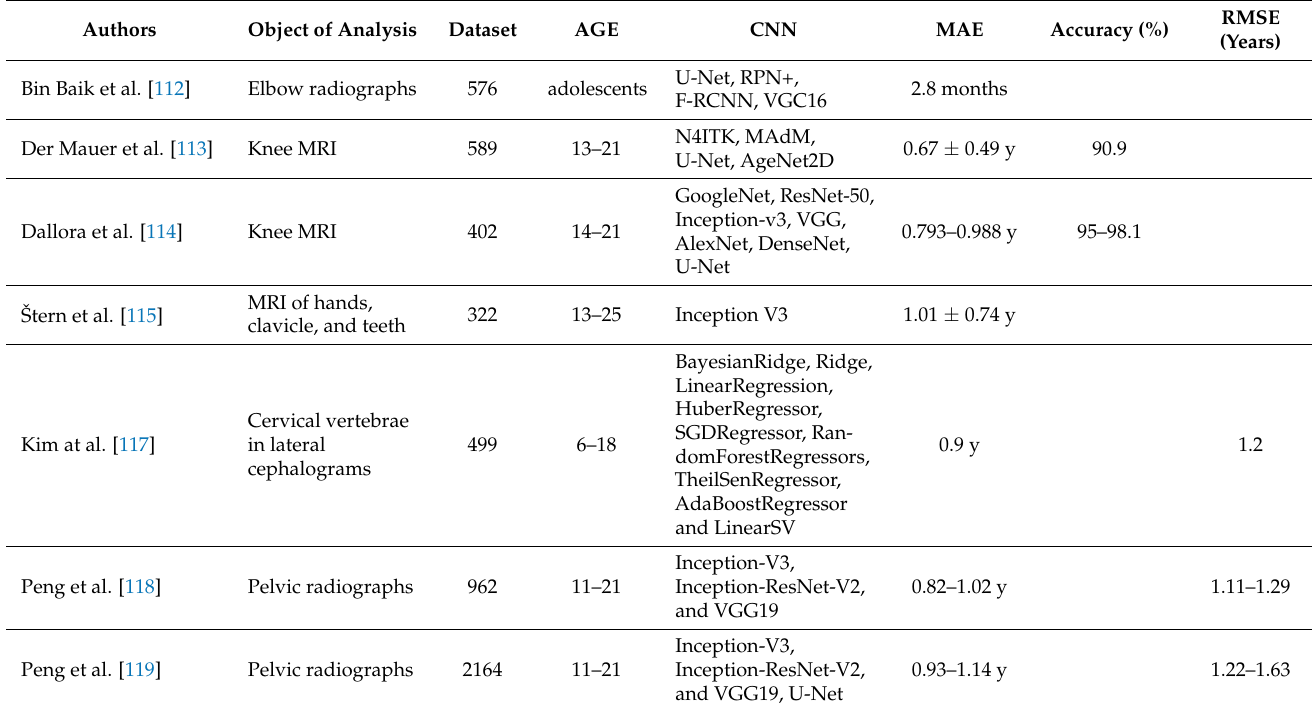
Table 5. The available AI applications for bone age estimation based on the analysis of skeletal segments different from